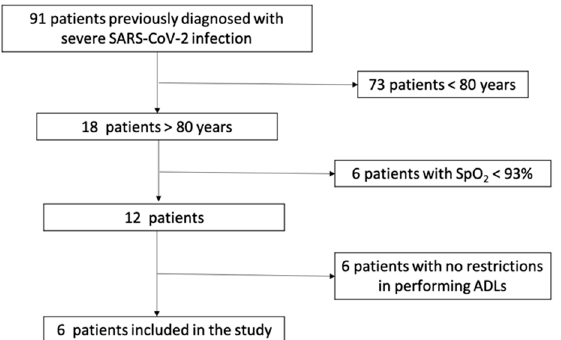
Figure 1. The flow chart of patients’ selection and inclusion criteria.